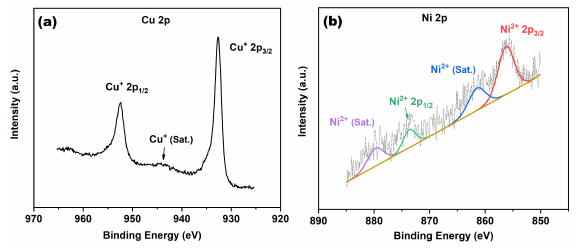
Fig. 4. XPS spectra of (a) Cu 2p and (b) Ni 2p for Cu 2 O/NiO